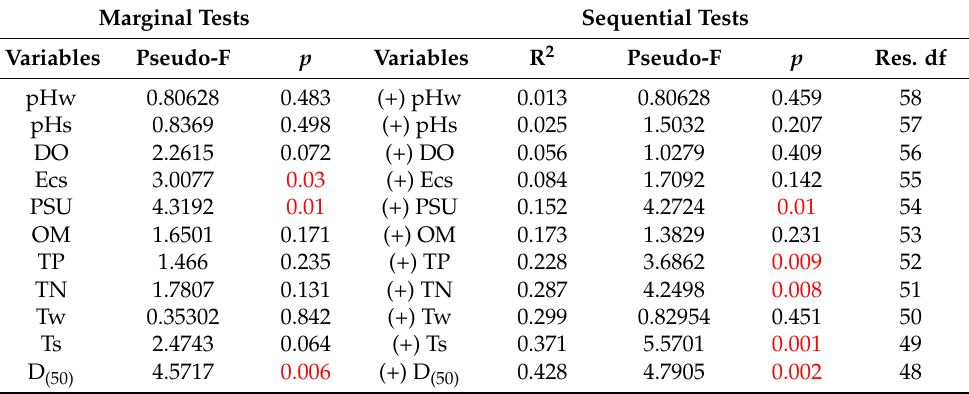
Figure 6. Meiofaunal diversity indices boxplots in downstream, ecotone, and upstream habitats along the Van Uc River in the dry season of 2021. Boxes display median, first and third quartiles, minimum, and maximum. Table 5. DistLM analysis results showing correlations between environmental variables and meio- faunal community attributes along the Van Uc River. Values in red indicate significant correlations ( p <